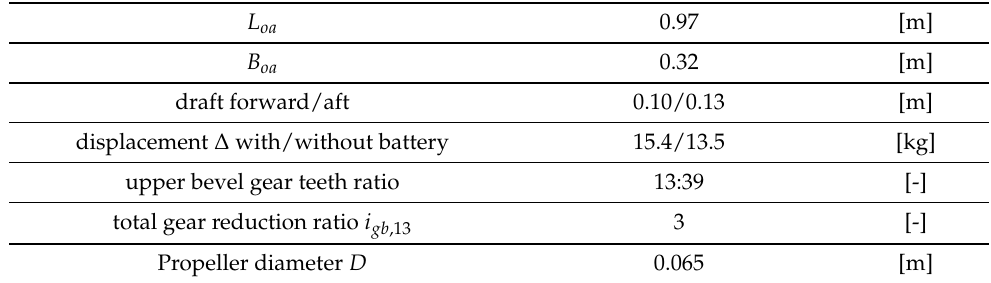
Table 1. Main particulars of Tito